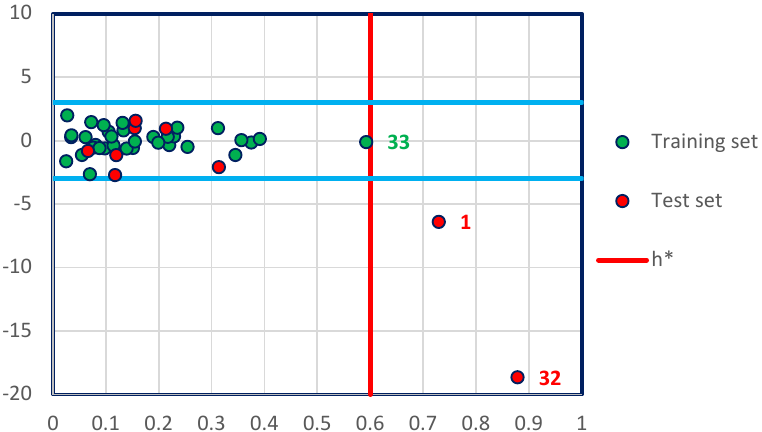
Figure 3. William’s diagram of the MLR model established by Equation (1). 1 and 32 are outliers in the test set and 33 is a non-aberrant molecule in the training test.